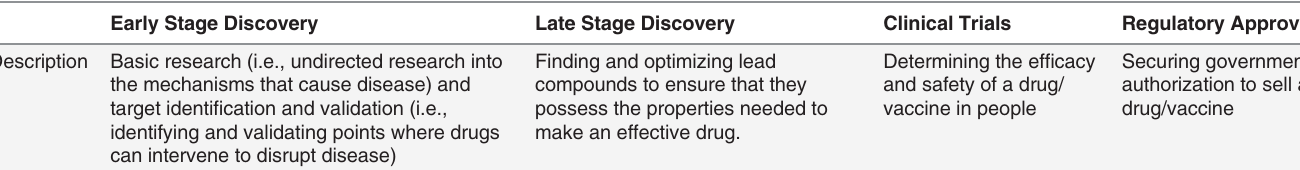
Table 1. The Pharmaceutical Value Chain